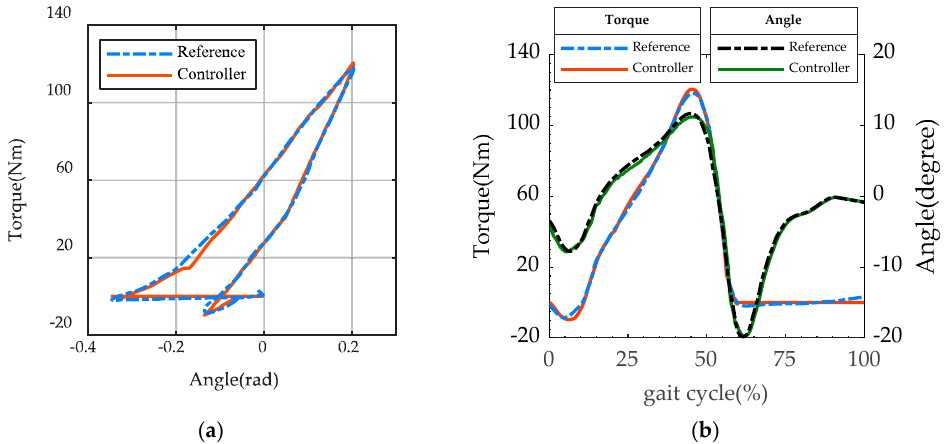
Figure 5. Simulation result of the optimization. ( a ) Simulative and reference quasi-stiffness. ( b ) Simulative ankle joint torque and angle with reference data.